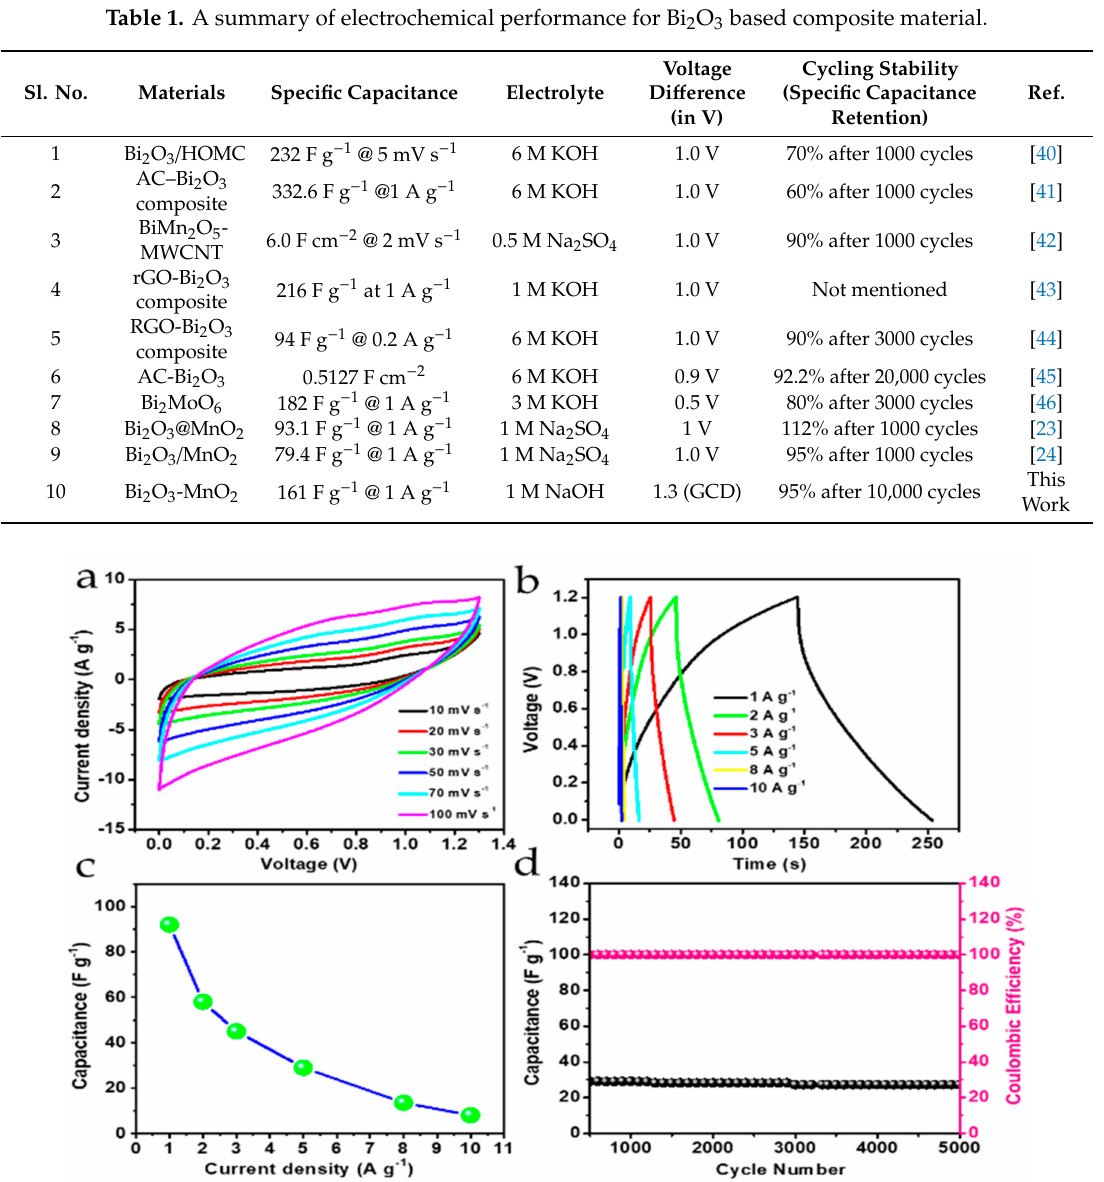
Figure 6. ( a ) CV, ( b ) GCD, ( c ) Rate capability, and ( d ) cycling performance of the Bi 2 O 3 -MnO 2 symmetric